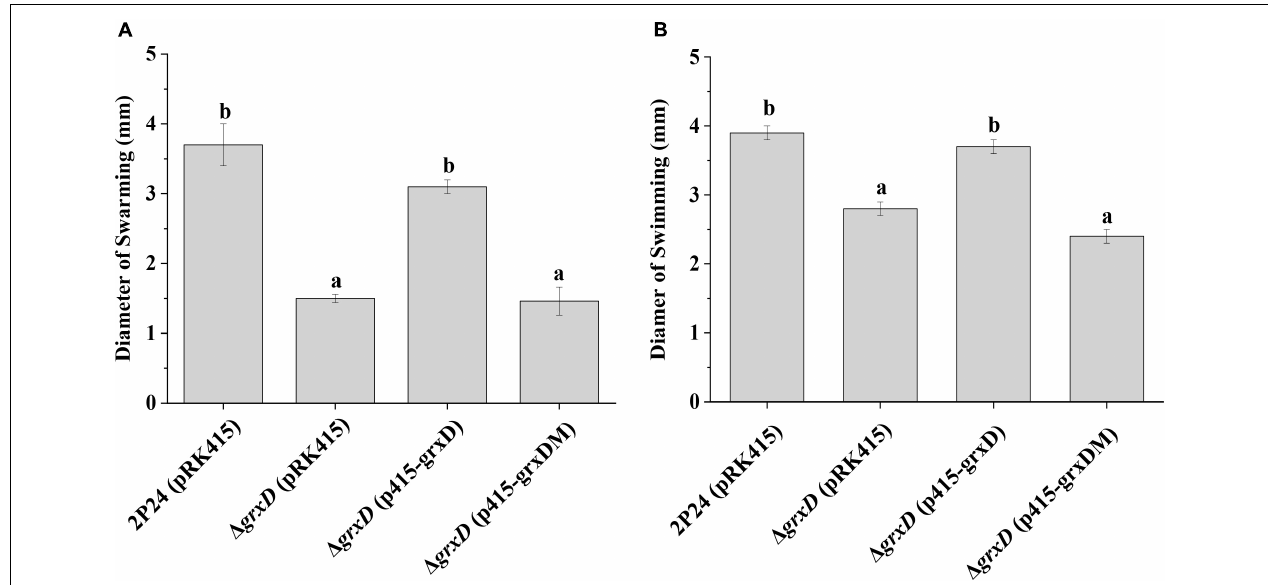
FIGURE 8 | Effect of the grxD gene on the motility of Pseudomonas fluorescens . (A) Swarming agar plate assay. The swarming abilities of strain 2P24 and its derivatives were determined by the diameter of the zone of motility. (B) Swimming agar plate assay. The swimming abilities of strain 2P24 and its derivatives were determined by the diameter of the zone of motility. The experiments were performed in triplicate, and different letters indicate a significant difference at the 0.05 level.